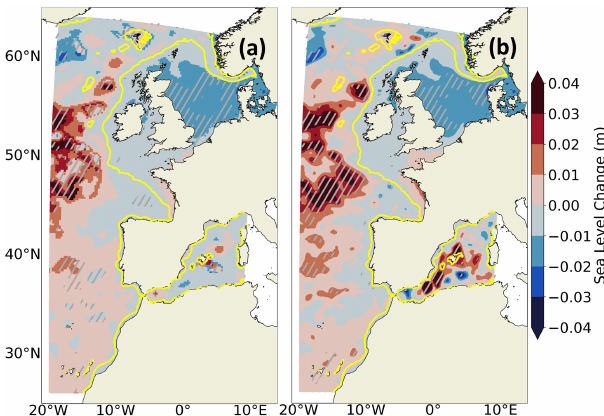
Figure 16. Projected changes (2081–2100 vs. 1986–2005) of SL in- terannual variability under the SSP5-8.5 scenario for the (a) GCM CNRM-CM6-1-HR and (b) IBI-CCS_corr. The interannual vari- ability is computed as the standard deviation of the detrended an- nual mean SL. A Fisher test has been performed with a confidence interval of 90%, and the significant changes between the two simu- lations have been marked with white dots. The shelf break (defined by the 200m isobath) is indicated in yellow.